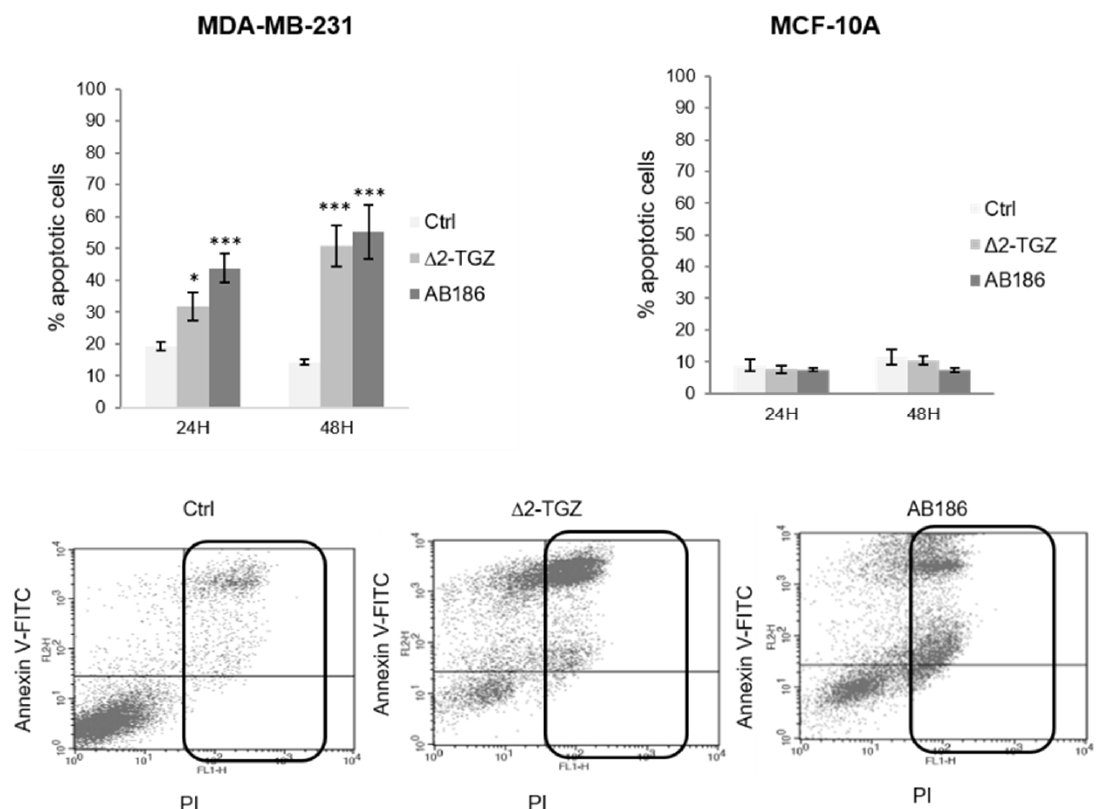
Figure 2. AB186 induces apoptosis in MDA-MB-231 TNBC cells. After treatment for 24 and 48 h with DMSO (Ctrl), 20 µ M of ∆ 2-TGZ or 4 µ M of AB186, MDA-MB-231 and MCF-10A cells were co-stained with FITC-Annexin V/PI and analyzed by FACS. The percentage of total apoptotic cells corresponds to Annexin V positive cells and Annexin V/PI positive cells (dot plot of MDA-MB-231 cells exposed to 48 h of treatment). The values represent the means ± SEM of three to six different experiments. ANOVA test with Bonferroni post-hoc was used to determine significant difference from control cells, where * p < 0.05 and *** p < 0.001.